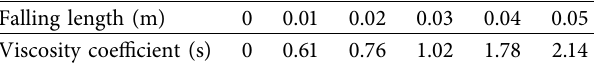
Table 2: The relationship between the falling displacement of the ball and